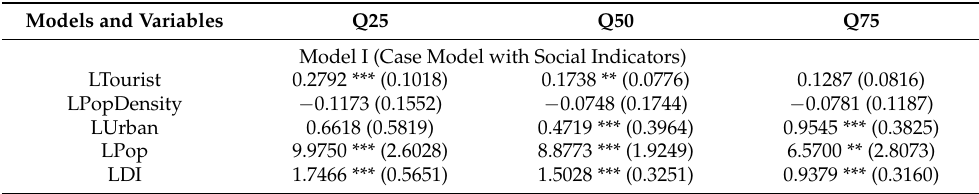
Table 2. Quantile Regression